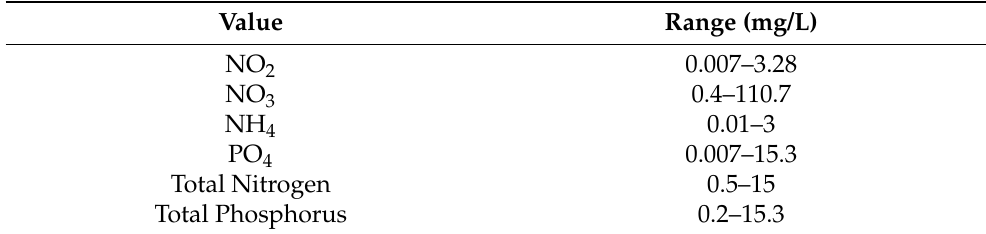
Figure 2. The NTSW pilot plant (adapted from Halicki and Halicki [12]). The three parallel wastewater treatment and water renewal processes are conducted in different daily hydraulic loads, namely 70, 100 and 130 L/m 2 for the A, B and C letters, respectively. ( a ) Compost beds. ( b ) Water renewal beds: denitrification beds (1), phosphorus beds (2) and activated carbon beds (3). ( c ) Setting of the NTSW pilot plant. Table 1. Measuring range of the water quality assessment methods used in this